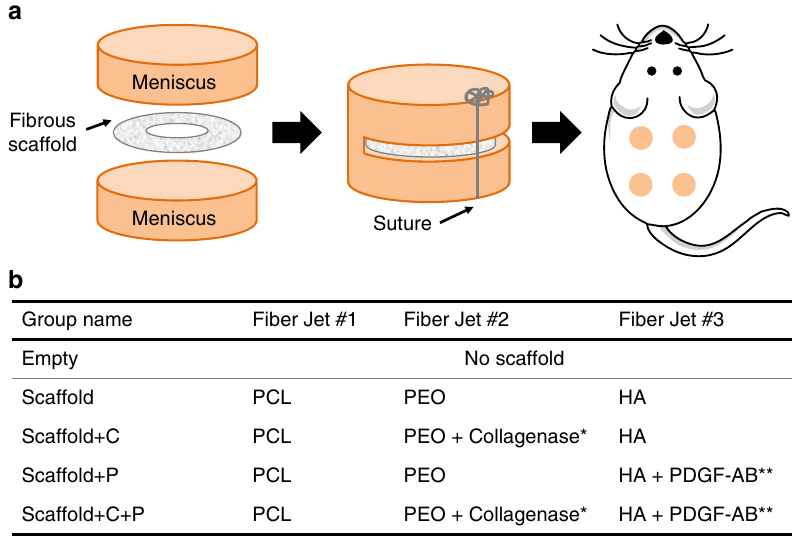
Fig. 5 Implantation groups to assess scaffold-mediated tissue repair. a Schematic of a repair construct consisting of a meniscal explant and scaffold that is placed subcutaneously in a nude rat. b Fiber and biomolecule composition of each scaffold group. Biomolecule loading (mass per scaffold) is based on electrospinning parameters and scaffold